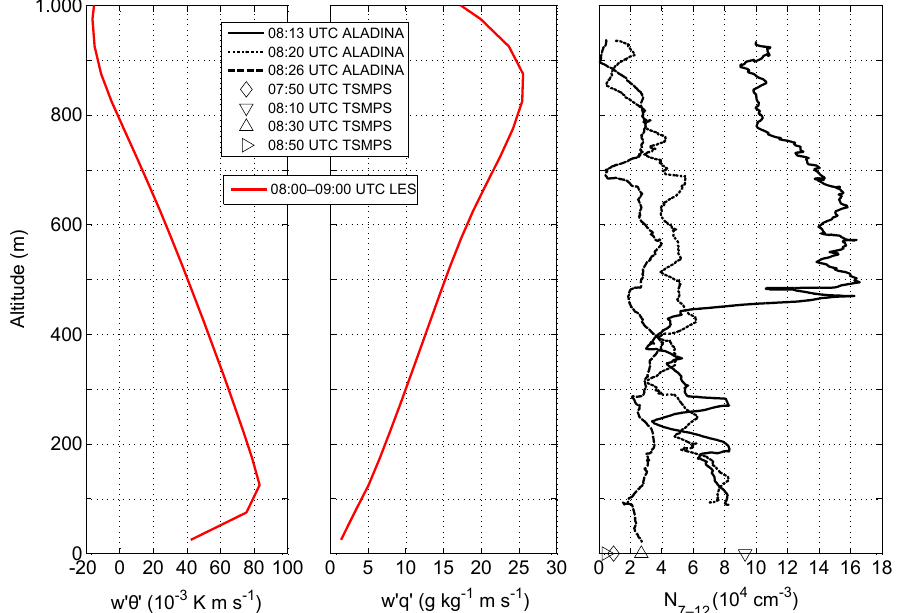
Figure 9. Vertical profiles of sensible heat flux w (cid:48) θ (cid:48) in Kms − 1 and latent heat flux w (cid:48) q (cid:48) in gkg − 1 ms − 1 obtained by LES output in the interval of 08:00–09:00UTC (red lines). Besides, three vertical profiles of freshly formed boundary layer aerosol in the particle diameter between 7 and 12nm ( N 7–12 ) measured with the CPCs on the UAS ALADINA at 08:13 (solid line), 08:20 (dotted line) and 08:26UTC (dashed line) are compared with the aerosol particle number concentration derived by TSMPS in the diameter range of 7 and 12nm at 07:50, 08:10, 08:30 and 08:50UTC. All data were derived during the MelCol experiment on 21 June 2015.